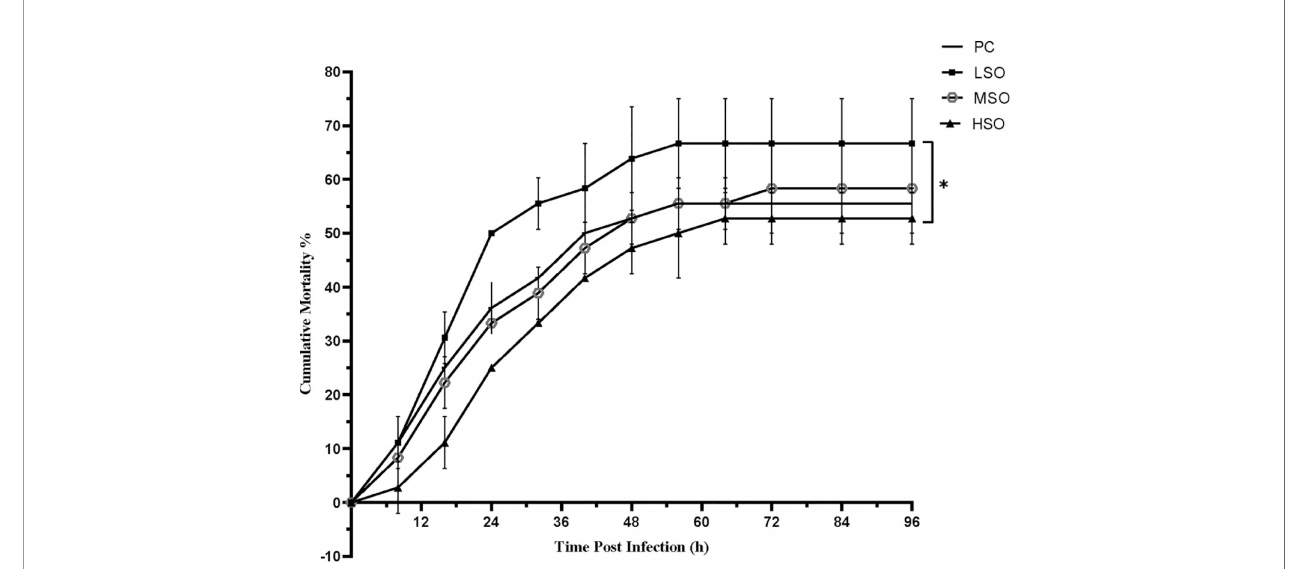
FIGURE 1 | Cumulative mortality of shrimp after infection of V. parahaemolyticus in this study. Asterisk (*) indicates signi fi cantly different ( p < 0.05) among groups based on Tukey ’ s multiple-test.